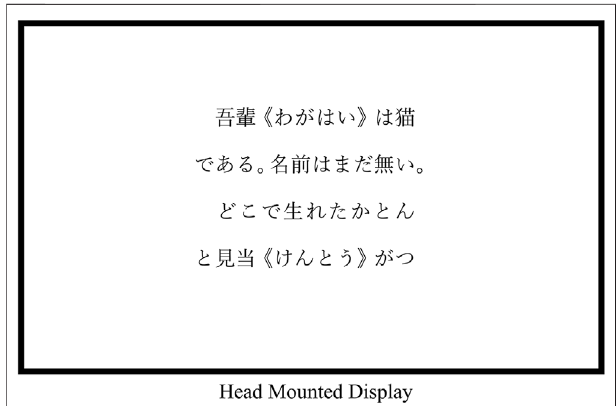
FIGURE 3 | VR environment of HMD reading task.